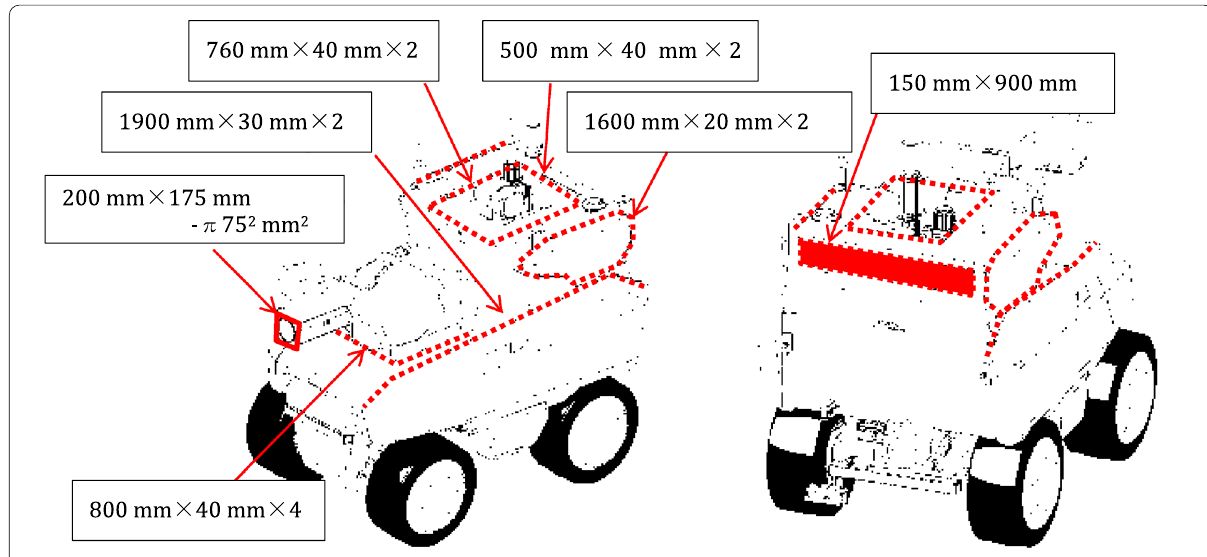
Fig. 15 Illustration of a water cannon robot opening